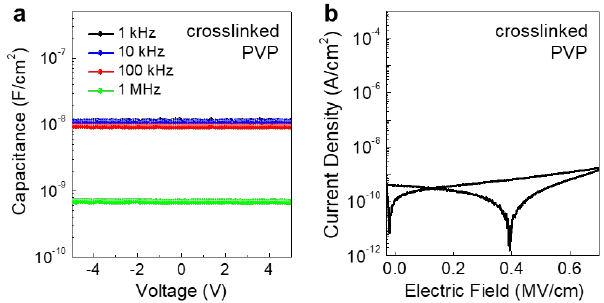
Figure 3. ( a ) Capacitance vs. frequency, and ( b ) the current density vs. electric field (J-E) characteristics of crosslinked PVP gate dielectric layer. The thickness of the PVP gate dielectric layer was ~718